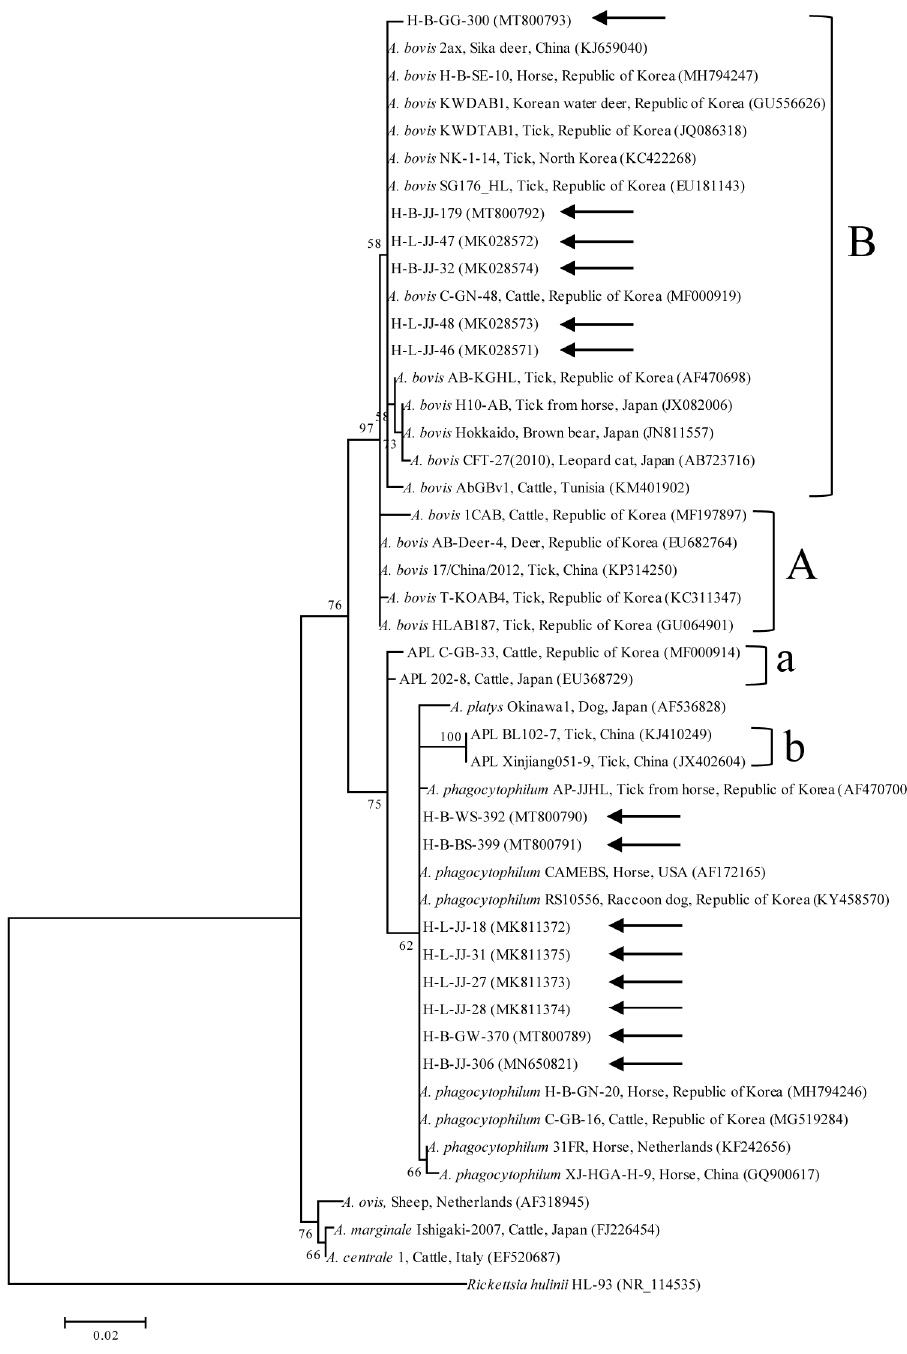
Figure 3. Phylogenetic tree created using the maximum likelihood technique with 16S rRNA nucle- otide sequences from Anaplasma . The sequences analyzed in this study are marked with arrows. The GenBank accession numbers of the additional sequences are listed adjacent to their respective se- quence names. Branch numbers indicate bootstrap support (1000 replicates). The scale bar represents the phylogenetic distance between the sequences. A. bovis clusters are denoted using “A” and “B.” A. phagocytophilum -like Anaplasma spp. clusters are denoted using “a” and “b.”